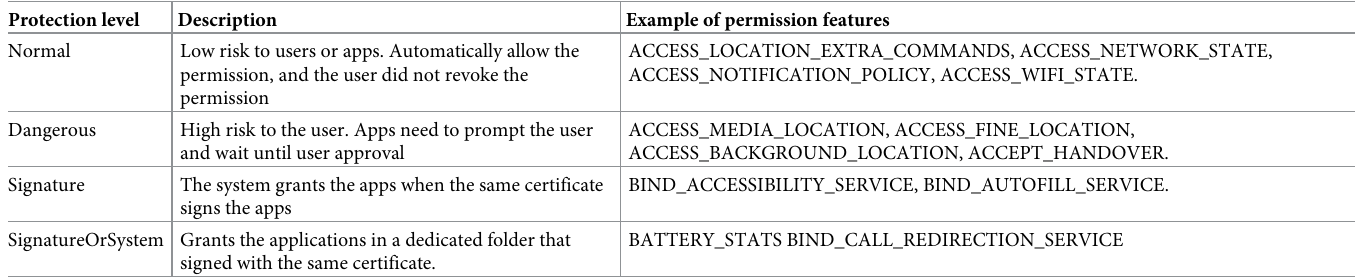
Table 2. Android permission protection